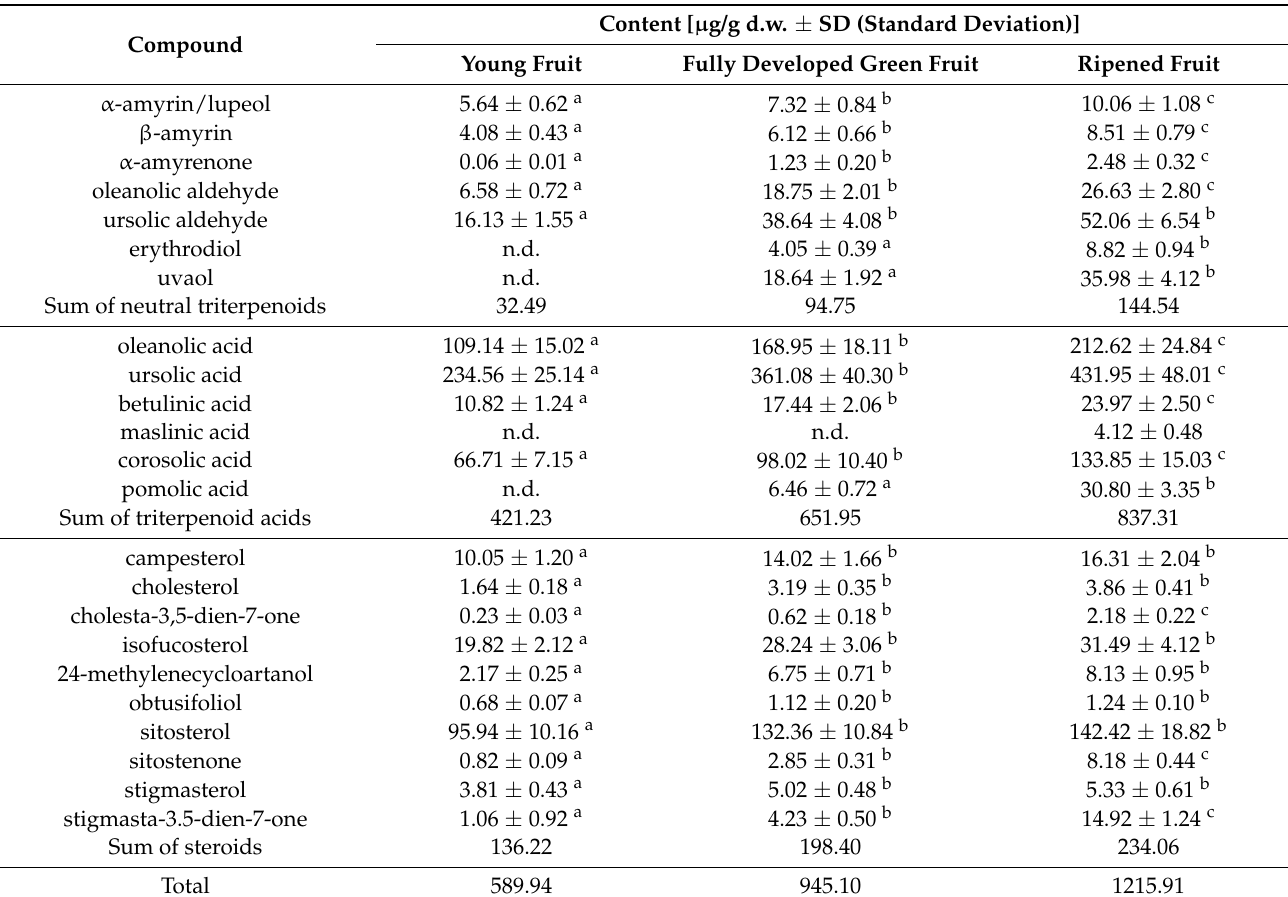
Table 1. Content of triterpenoids and steroids in hypanthium during rugosa rose ( Rosa rugosa ) fruit development.